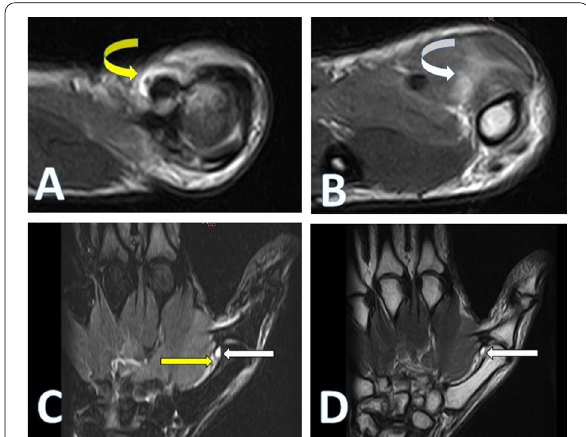
Fig. 4 Male patient 36 years old, complaining of right thumb pain, swelling and limitation of movement following finger trauma. Axial T2WI ( a , b ) of the right thumb revealed fluid signal surrounding the flexor pollicis longus tendon (curved yellow arrow) and edematous changes of the thenar muscles (curved white arrow) and the metacarpophalangeal region. Coronal STIR ( c ) and coronal proton density ( d ) weighted imaging of the right thumb at the level of the metacarpophalangeal (MCP) joint showed no definite proximal attachment of the medial collateral ligament (straight yellow arrow) with surrounding hyperintense fluid signal and mild metacarpophalangeal joint effusion (straight white arrow). Diagnosis was right thumb ulnar collateral ligament tear at the level of the metacarpophalangeal joint with tenosynovitis of the flexor pollicis longus and mild metacarpophalangeal joint effusion